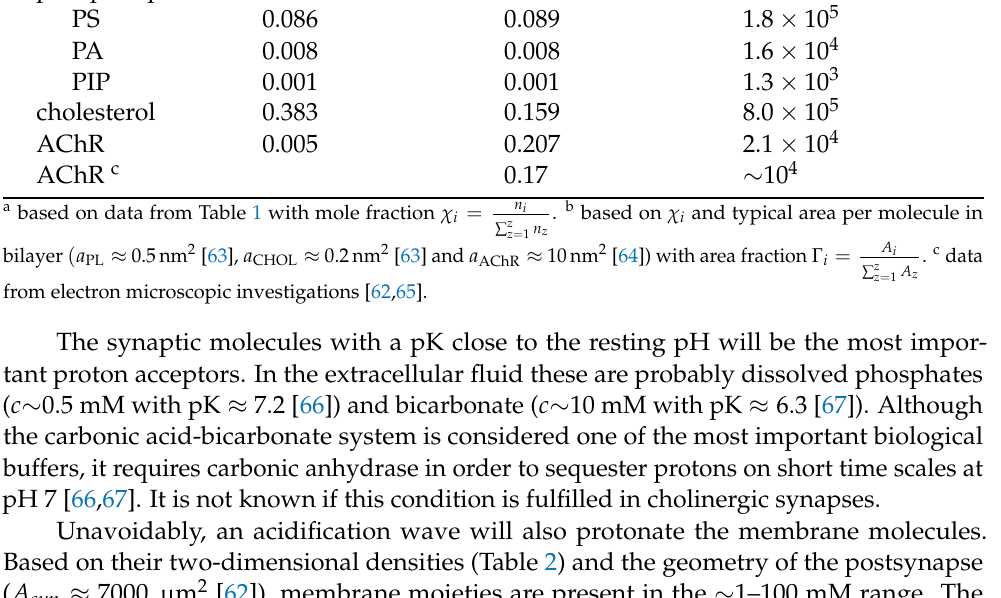
Table 2. Approximate mole and area fractions as well as 2D-densities of phospholipids (phos- phatidylserine (PS), phosphatidic acid (PA) and phosphorylated phosphatidylinositol (PIP)), choles- terol as well as AChR in postsynaptic membrane.